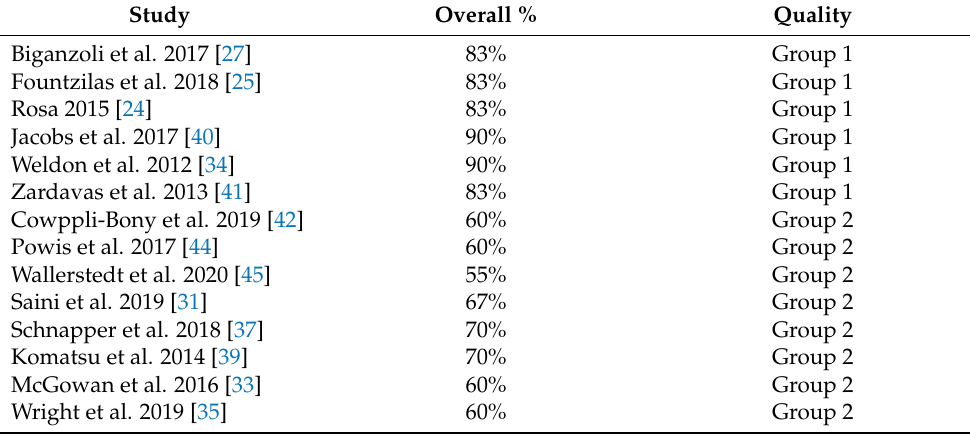
Table 1. Summary results of quality assessment.